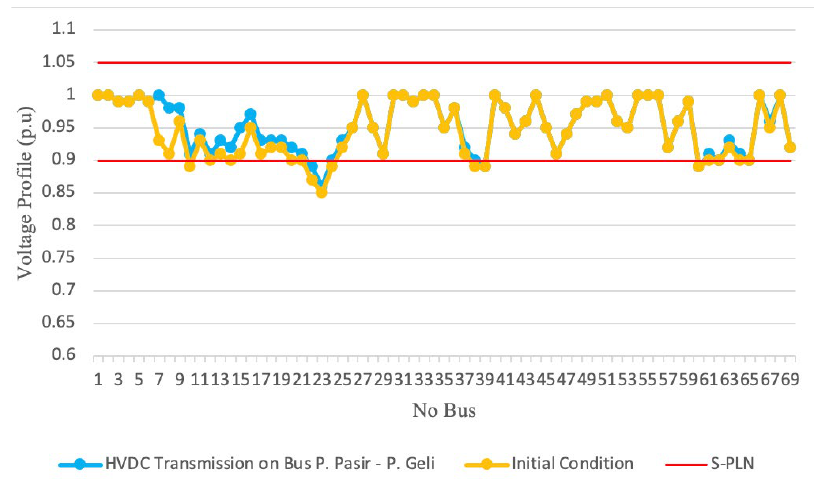
Figure 7. Voltage profile of the SUMBAGUT 150 kV transmission system after changing the Paya Pasir (Bus 5)–Paya Geli (Bus 7) line to the HVDC transmission system. 3.3.2. Paya Pasir (Bus 5)–Sei Rotan (Bus 11)